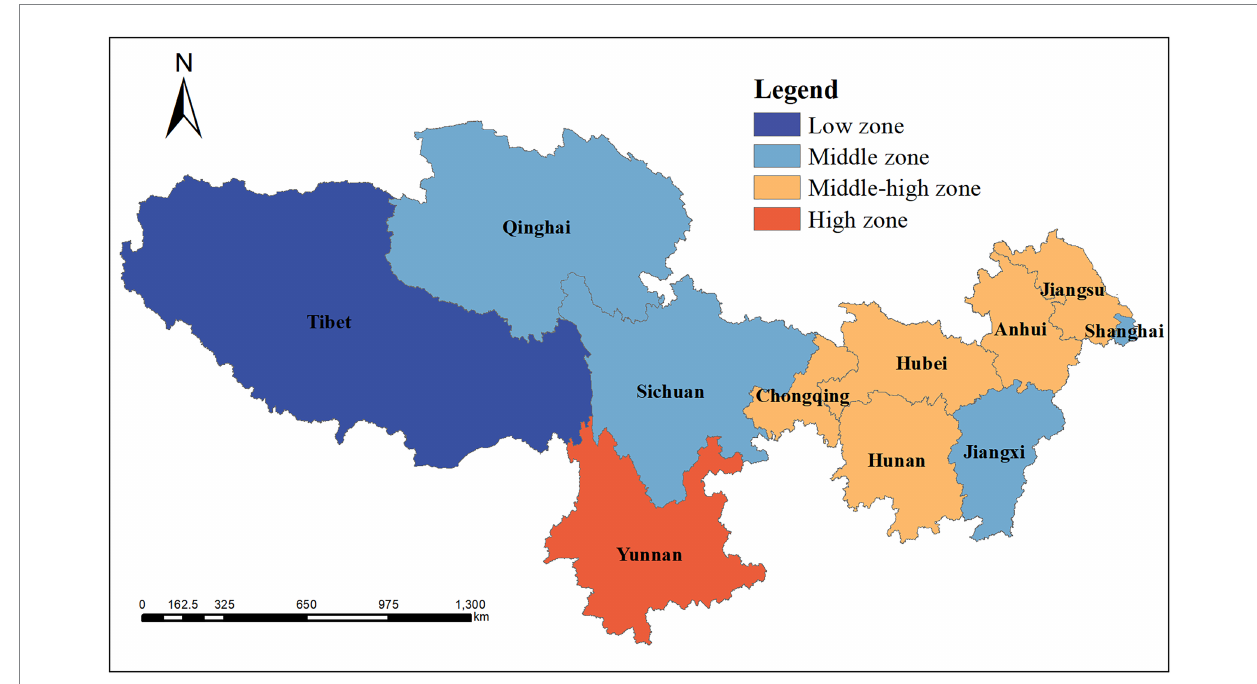
FIGURE 8 Spatial patterns of ecological environment pressure in the Yangtze River basin.